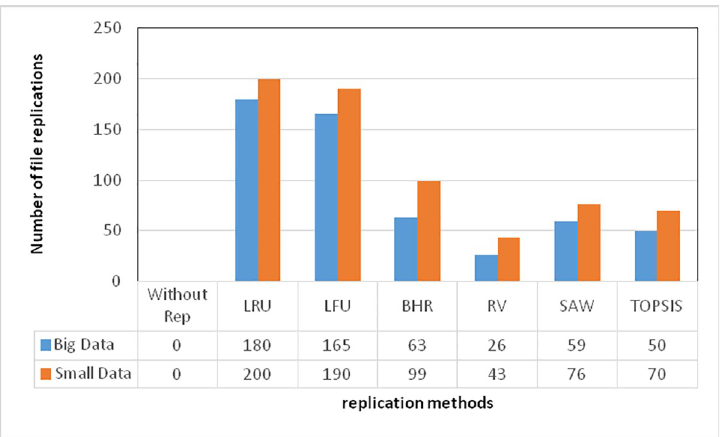
Fig 3. A comparison of the number of replicated files in the examined